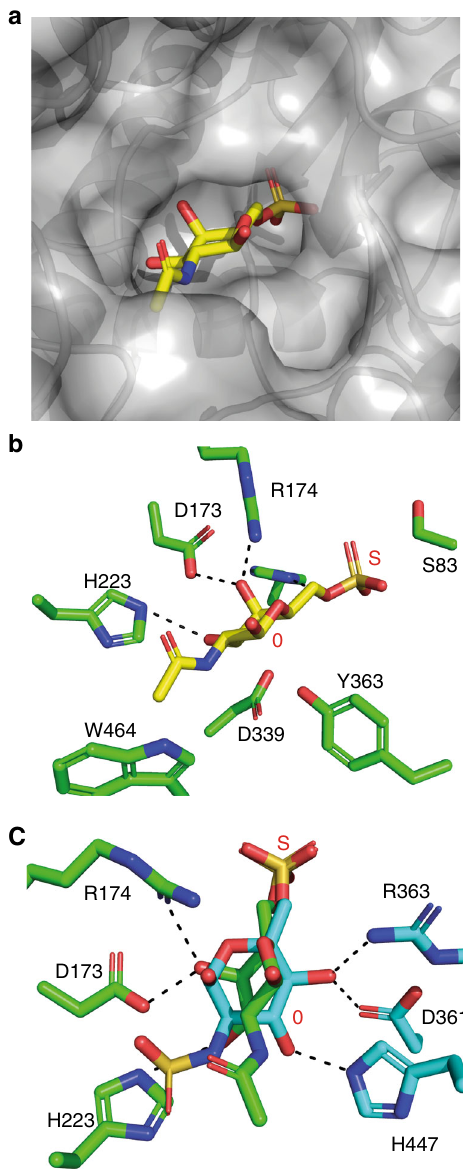
Fig. 5 Structural depictions of BT3333-S1_15 6S-sulf and it comparison with BT4656 6S-sulf . a A close up of a surface representation showing the pocket topography of BT3333-S1_15 6S-sulf ; b stick representations of the binding site interactions with the protein in green and GalNAc6S in yellow; c overlay of BT3333-S1_15 6S-sulf in complex with GalNAc6S (green)